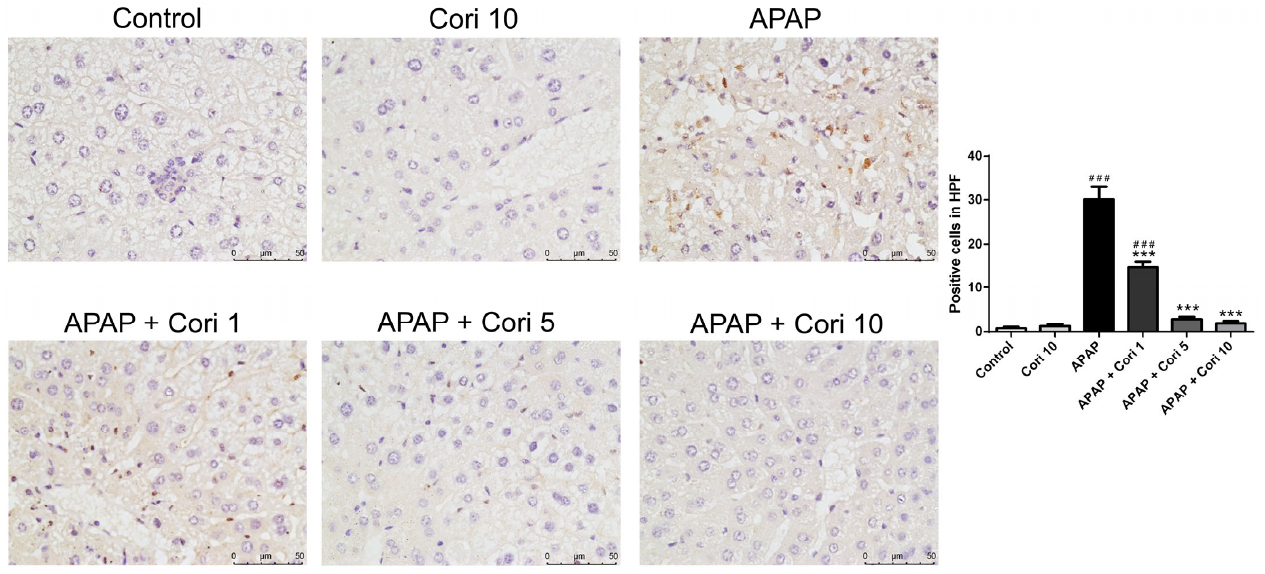
Figure 7. The effects of corilagin on NOX2 expression. Animals were injected with APAP (300 mg/kg) or equal volume of saline (control), and treated with corilagin (0, 1, 5, or 10 g/kg) (400 × ). Each value represents mean ± SEM; n = 6 for each group. ### p < 0.005 vs. control group; *** p < 0.005 vs. APAP